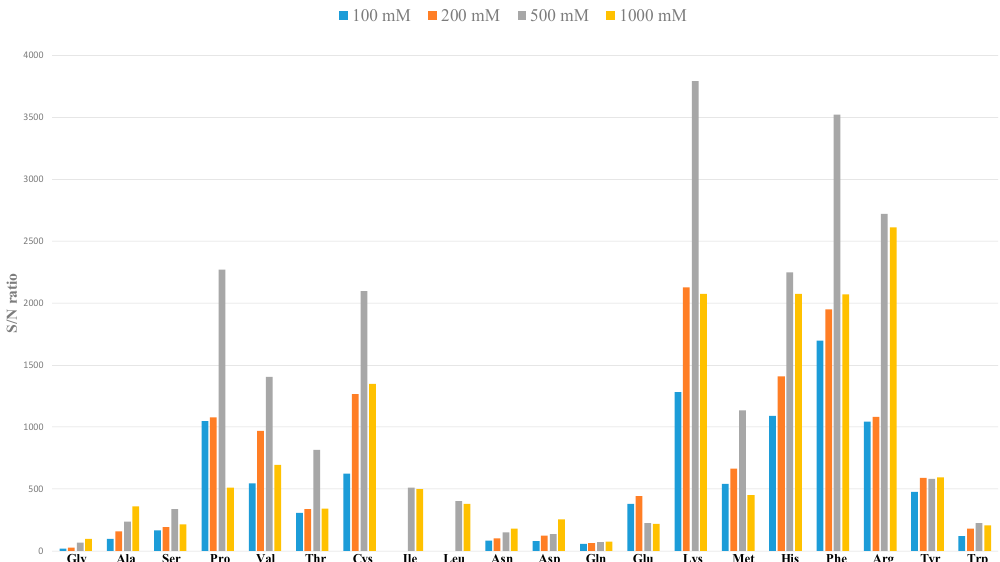
Figure 2. Effect of the concentration of formic acid in BGE on the signal to noise ratio (S/N) of 20 proteinogenic amino acids in water solution. Concentration of all amino acids injected into the electrophoretic analyzer was 100 µM, except from cysteine (50 µM). For the CE-MS/MS method details see Section 3.